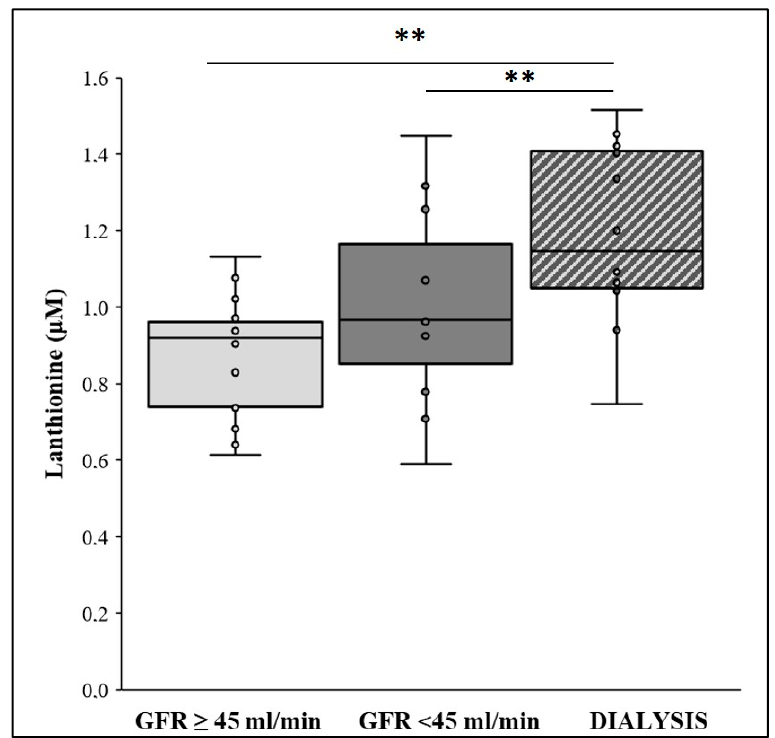
Figure 1. Plasma lanthionine levels in GFR ≥ 45 mL/min/1.73 m 2 , GFR < 45 mL/min/1.73 m 2 , and dialysis patients. Plasma lanthionine was measured by UHPLC/MS system (Ultimate 3000/LTQXL Thermo Scientific), in positive mode, and concentration is expressed as μ M values. GFR ≥ 45 mL/min/1.73 m 2 : n = 14; 37.83%; GFR < 45 mL/min/1.73 m 2 : n = 11; 29.72%; and Dialysis: n = 12; 32.43%. Within each box, the horizontal black lines represent the median values. p -values: GFR ≥ 45 mL/min/1.73 m 2 and GFR < 45 mL/min/1.73 m 2 versus dialysis ** p < 0.01, according to the Mann–